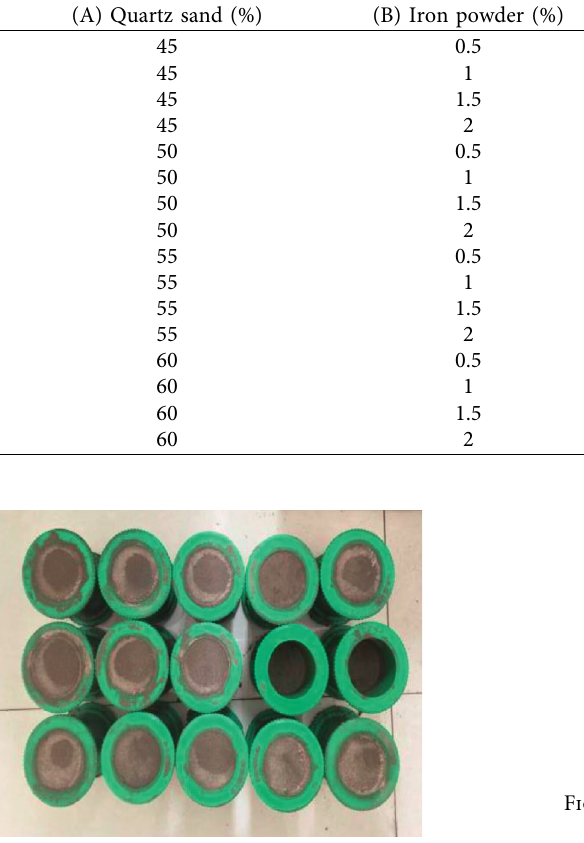
Figure 2: Sample preparation of similar materials covered by the study.